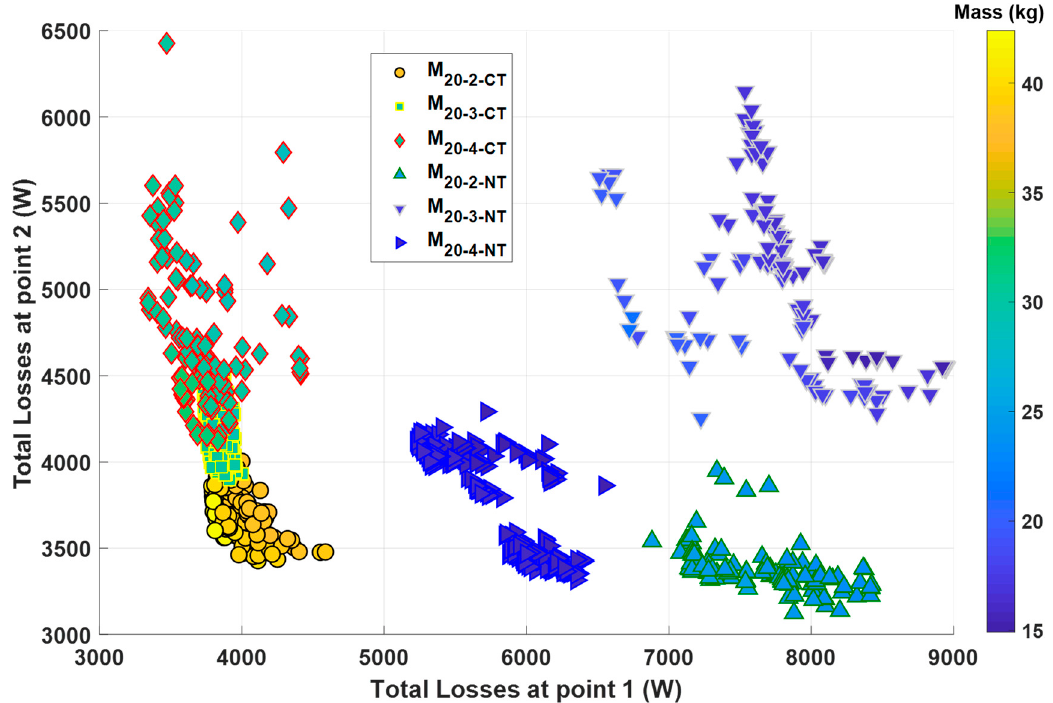
Figure 10. Pareto front of all electric machines operating at Ω (cid:3040)(cid:3028)(cid:3051) = 20,000 𝑟𝑝𝑚. For classic technologies, machines with p = 4 have the lowest losses at point 1 (3.3–4.4 kW), the highest losses at point 2 (4.1–6.5 kW), and low mass (28.5–32.5 kg). Machines with p = 3 have medium losses at point 1 (3.7–4 kW), medium losses at point 2 (3.9–4.5 kW), and low mass (28.5–30.5 kg). Machines with p = 2 have the highest losses at point 1 (3.8–4.6 kW), the lowest losses at point 2 (3.4–4.3 kW), and high mass (38–42.3 kg). Ma- chines with p = 3 can be considered the best candidates regarding their good efficiency and low mass. For new technologies, machines with p = 4 have the lowest losses at point 1 (5.2–6.6 kW), low losses at point 2 (3.3–4.3 kW), and low mass (15–16.2 kg). Machines with p = 3 have high point 1 losses (6.5–9 kW), high point 2 losses (4.2–6.1 kW), and low mass (15–21 kg). Machines with p = 2 have high losses at point 1 (6.9–8.4 kW), low losses at point 2